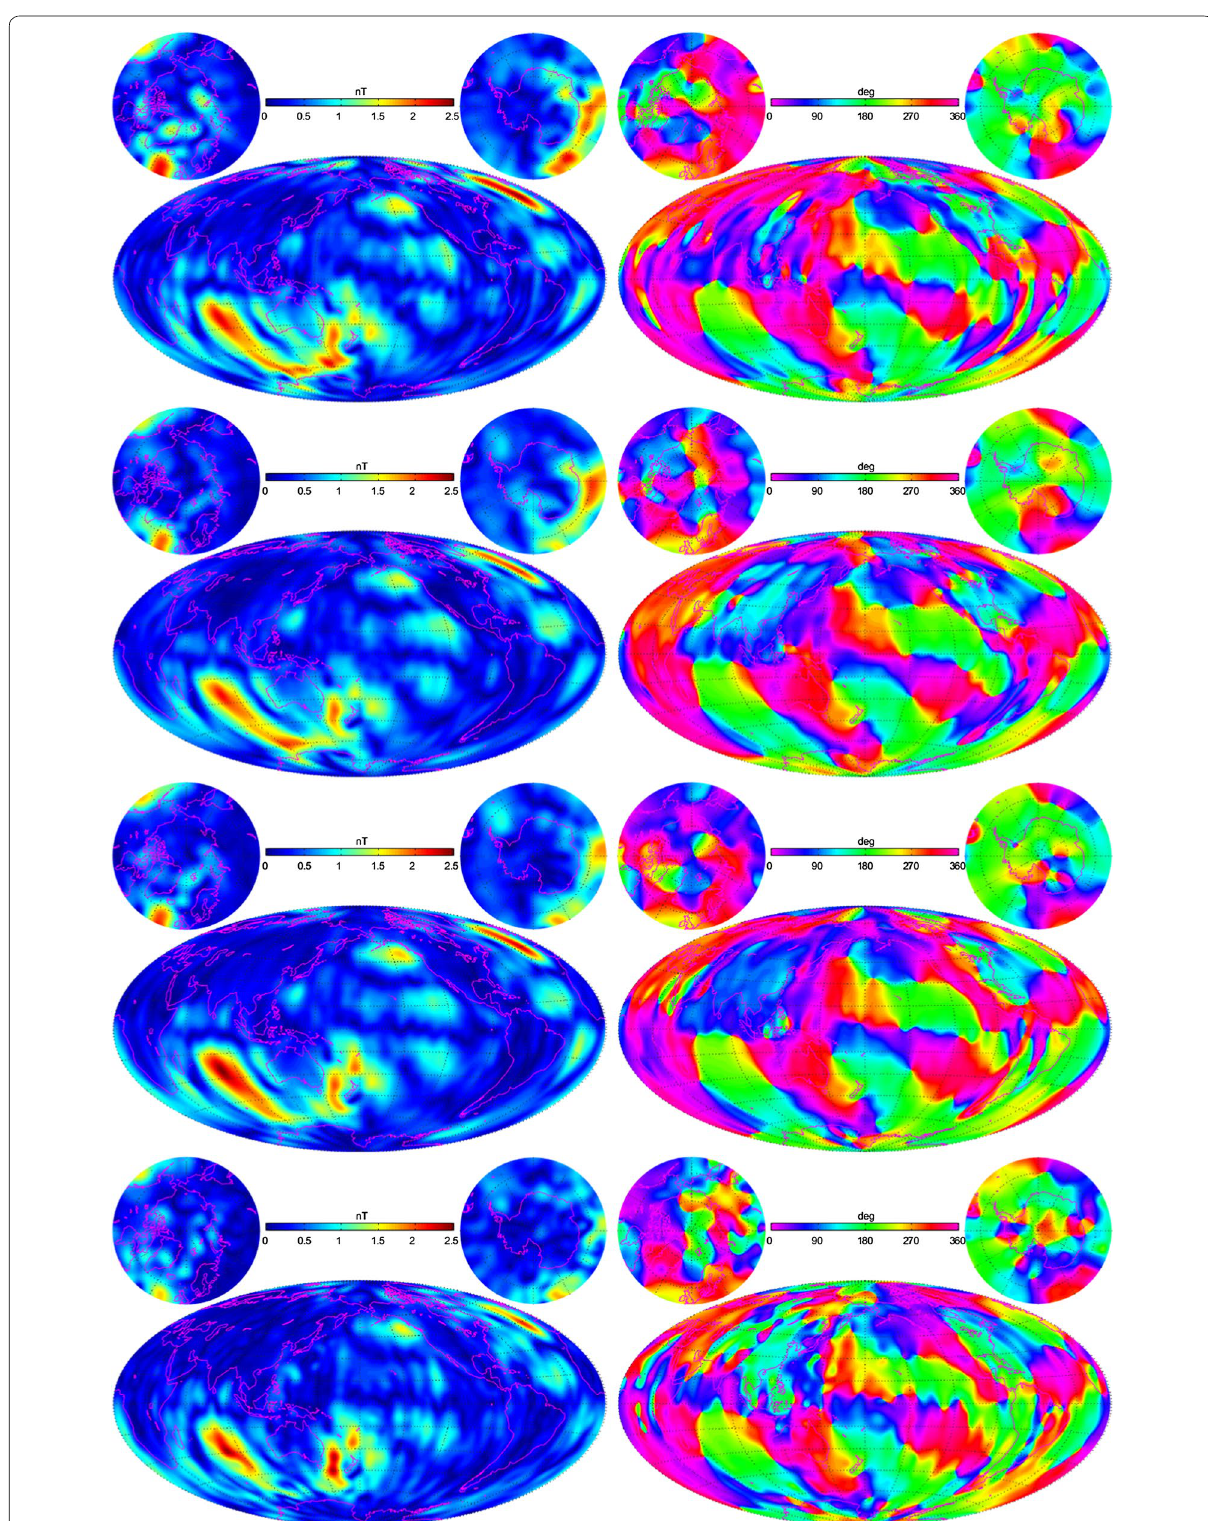
Fig. 10 The amplitude (left) and phase (right) of the radial component of the oceanic M 2 tidal magnetic field at 430km altitude as estimated from, starting at the top, 2, 3, and 4 (CIY4) years of Swarm data and from CHAMP data (CM5) for SH degrees n = 1 −